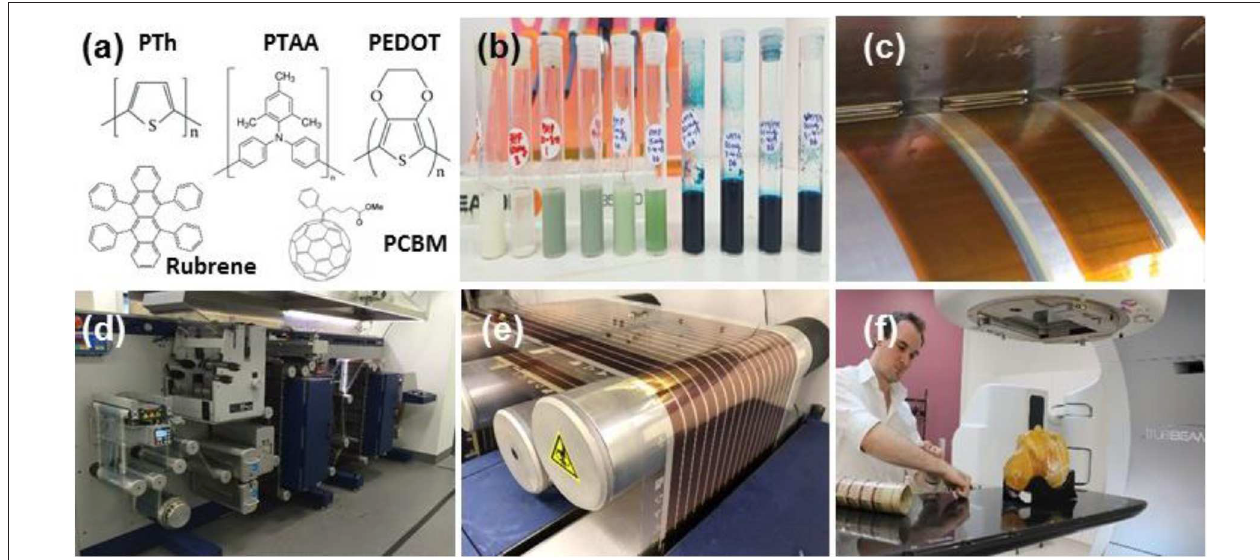
FIGURE 1 | (a) Chemical structure of some organic semiconductors (OSCs) used to detect radiation [PTh, poly(thiophene); PTAA, poly(triarylamine); PEDOT, poly(ethylenedioxythiophene); Rubrene; PCBM, phenyl-C 61 -butyric acid methyl ester). (b) several different organic scintillator and semiconductor materials dissolved into printable inks. (c) Image of a dielectric ink being printed onto a semiconducting polymer for radiation detectors. (d) A roll-to-roll coating machine printing OSC inks. (e) An image of large area organic semiconducting materials printed at industrial scale. (f) Printed flexible organic radiation detectors fabricated at the University of Newcastle’s Center for Organic Electronics. The authors have confirmed that any identifiable participants in this study have given their consent for